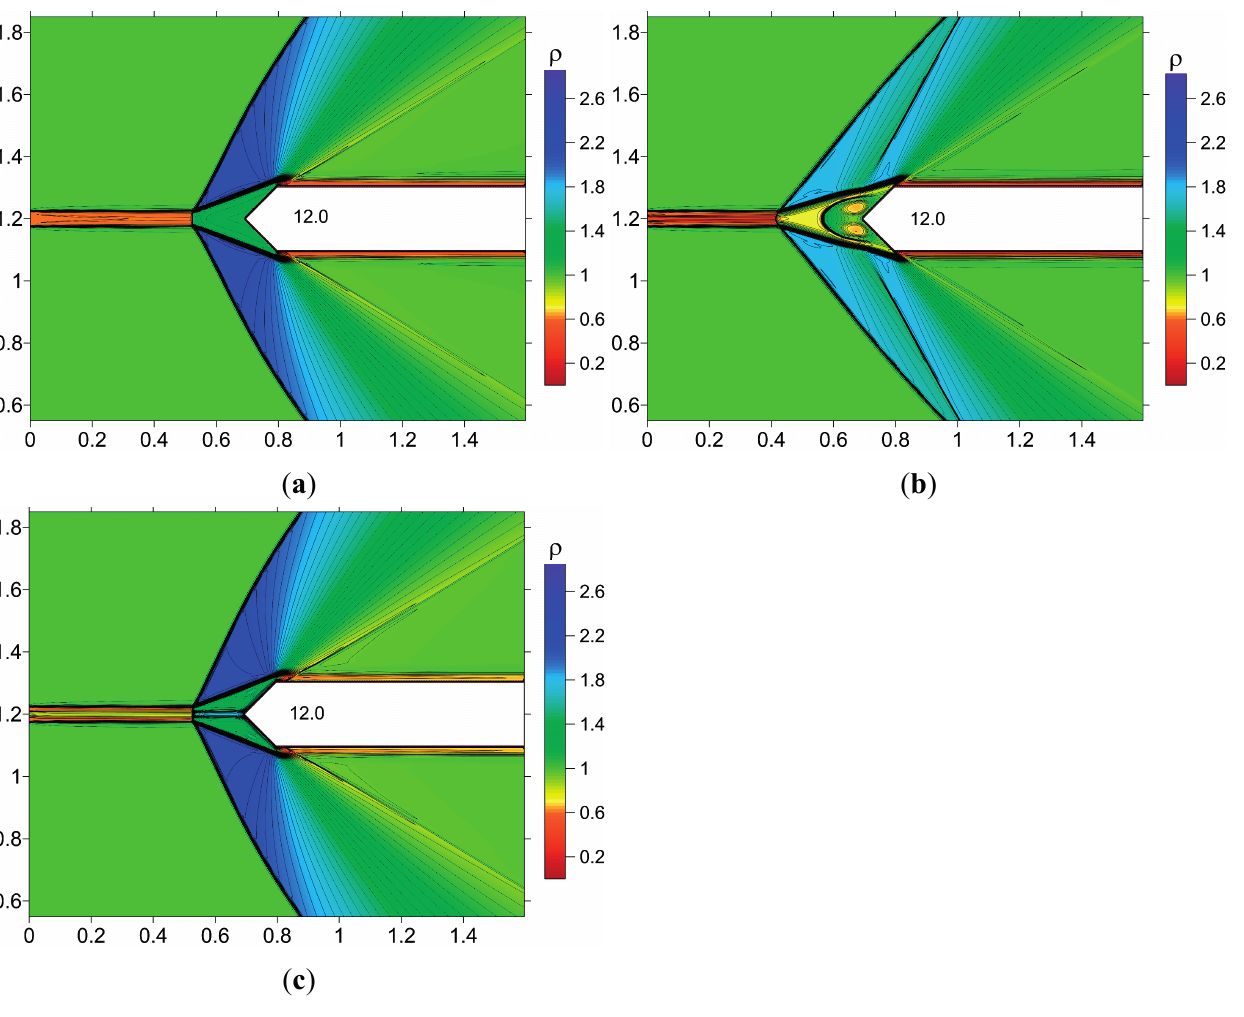
Figure 11. Steady fields of density, α ρ = 0.6: ( a ) Non-combined filament; ( b ) Combined filament, α ρ 1 = 0.4; ( c ) Combined filament, α ρ 1 =